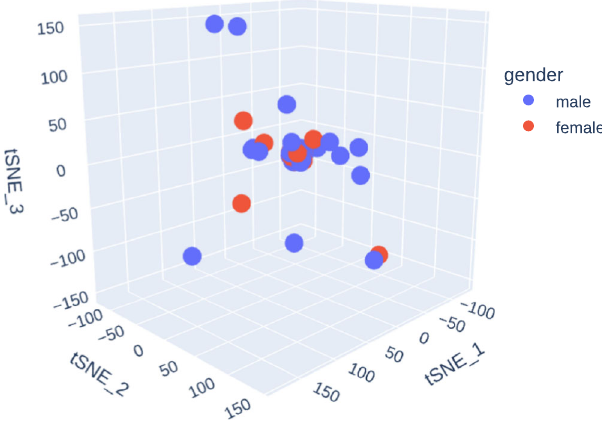
Fig. 8 t-SNE plots of characters based on their emotions. Gender-wise clustering of characters based on their